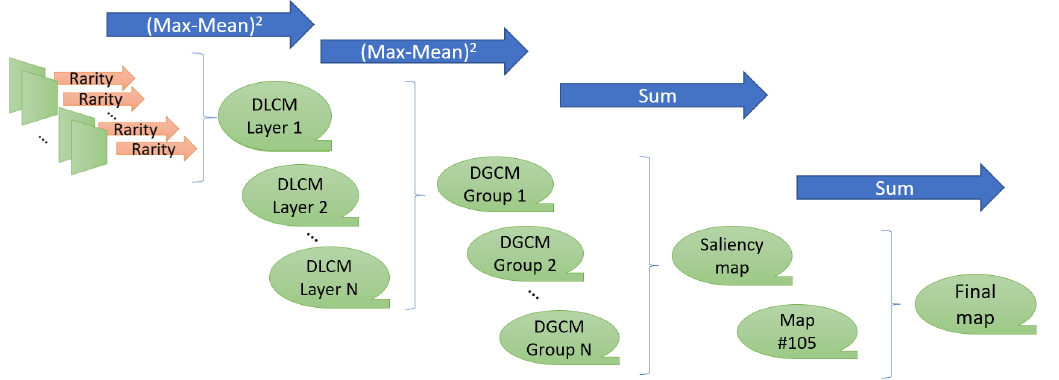
Figure 6. Details on the fusion techniques. The last step using map #105 is optional and only makes sense for a VGG16 architecture.